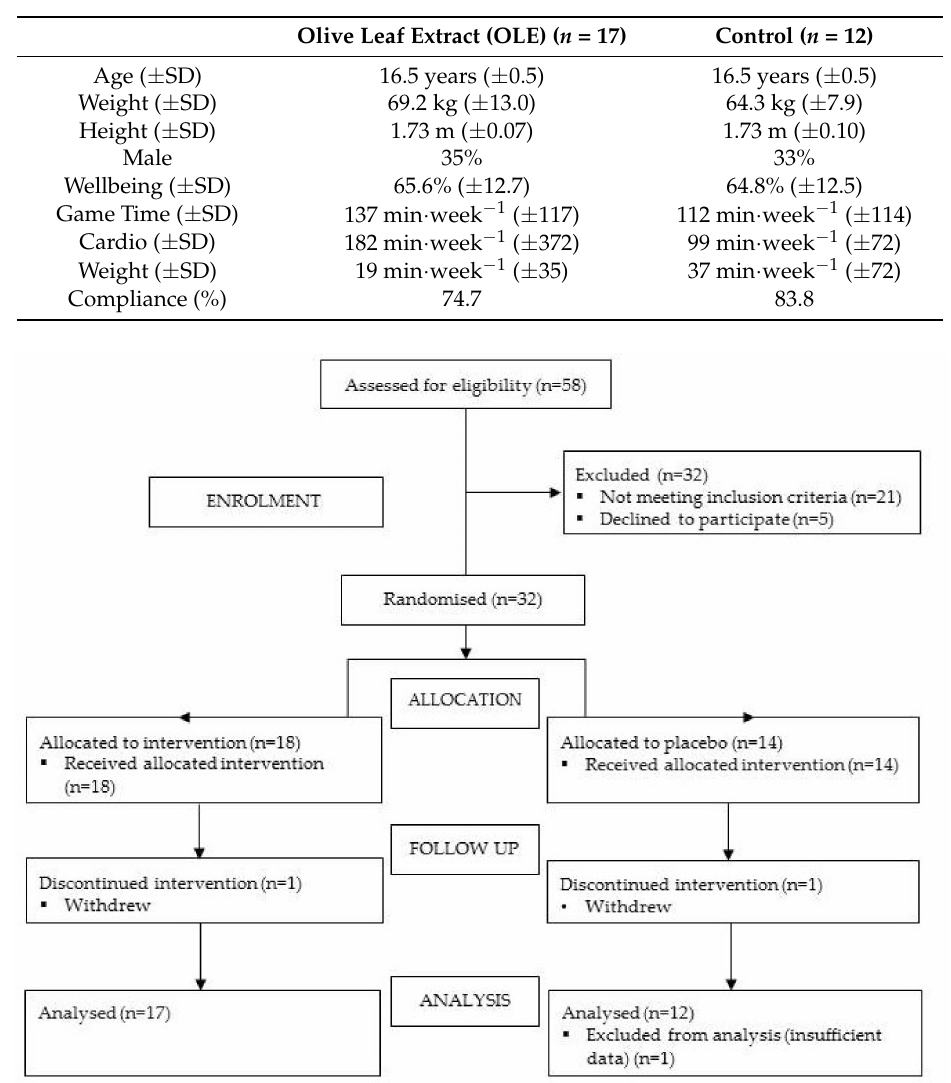
Table 1. Population characteristics of included participants.